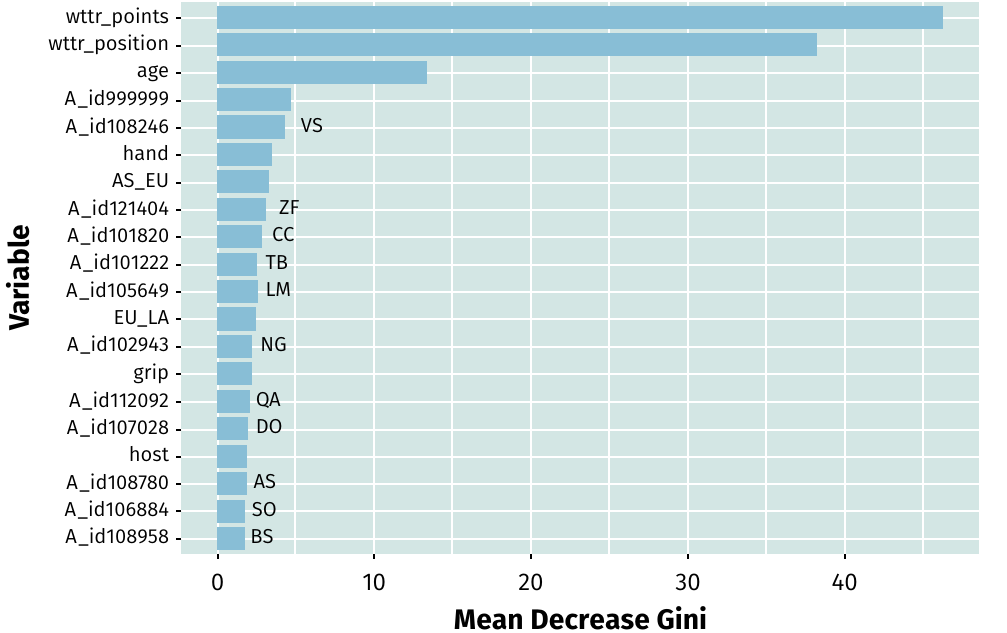
Predicting Table Tennis Tournaments: A comparison of statistical modelling techniques